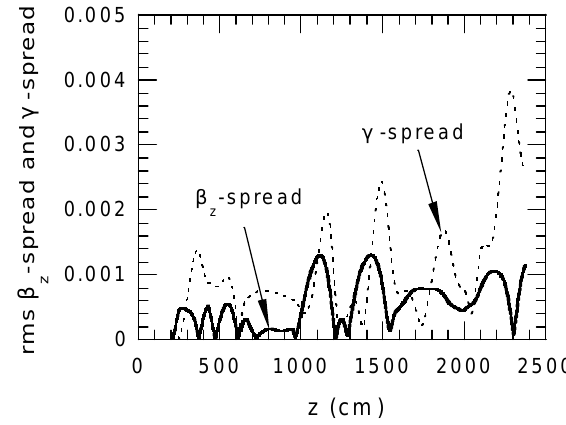
FIG. 4. rms spreads in proton energy factor and axial velocity along the accelerator. These spreads are nearly zero in the first cavity, since the injected beam is taken to have zero emittance. The oscillatory character of these spreads is evidence of dynamic (transverse) stabilization.